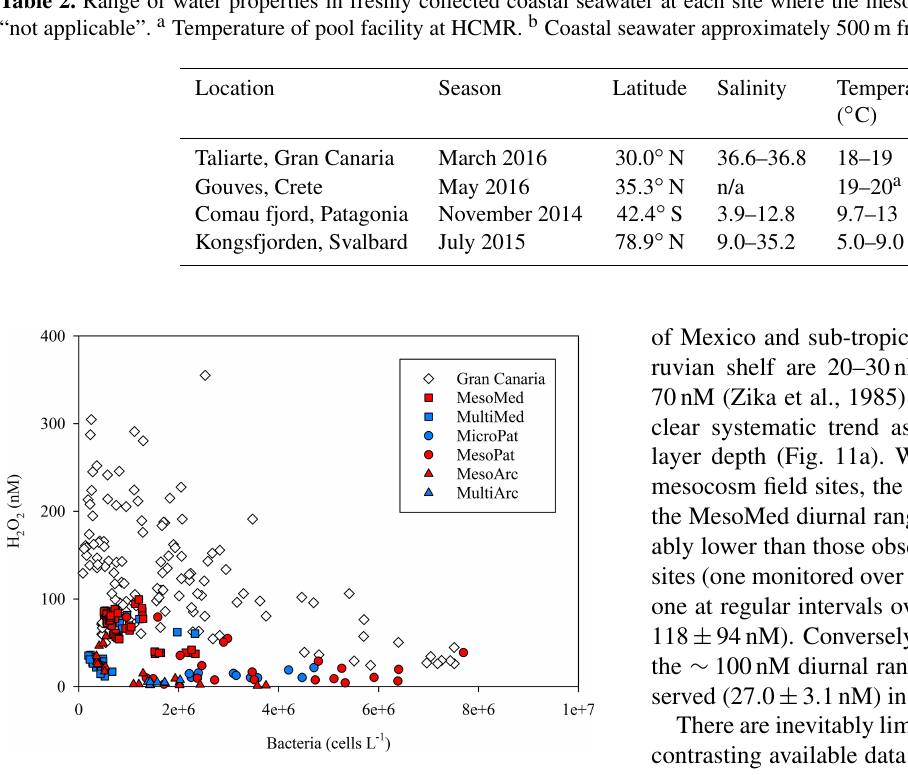
Table 2. Range of water properties in freshly collected coastal seawater at each site where the mesocosms were conducted. “n/a” denotes